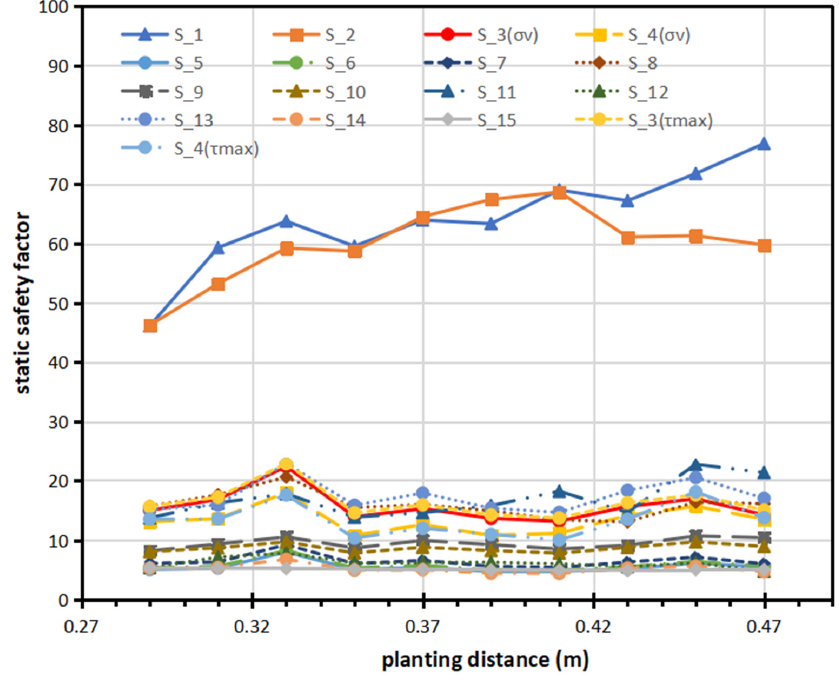
Figure 12. The average static safety factor of the transplanting device according to the planting dis- tance.